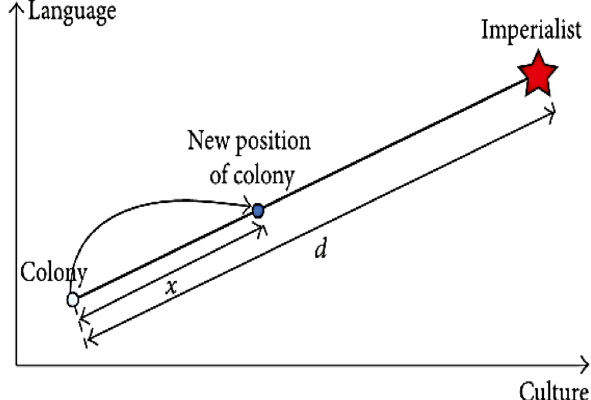
Fig. 4 Moving the colony toward the relevant imperialist (Khalili et al.